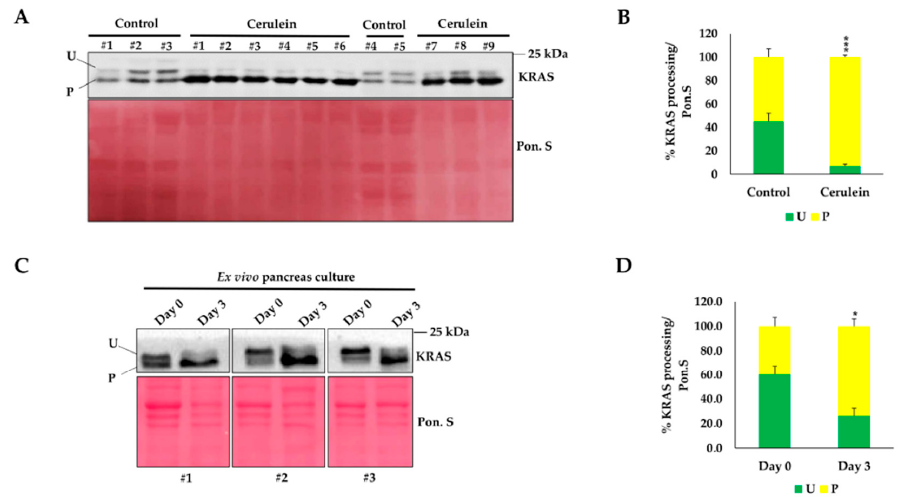
Figure 5. Impact of pancreas inflammation on KRAS prenylation. ( A ) Western blot on pancreas lysates from Ela-Kras G12D /+ mice treated ( n = 9) or not ( n = 5) with cerulein for 1 week. This result shows the di ff erential profiles of KRAS prenylation in the presence and absence of inflammation. ( B ) Densitometry quantification, from panel A, of unprenylated (green) and prenylated (yellow) KRAS forms normalized to Ponceau S (Pon.S), which is used as a loading control. ( C ) Western blot performed on protein lysates from ex vivo pancreas cultures at day 0 and day 3 using antibody #5 ( n = 3). Day 0 is equivalent to a normal pancreas and day 3 is equivalent to a metaplastic pancreas, similar to that observed in the presence of inflammation. ( D ) Densitometry quantification from panel C showing the proportion of unprenylated (green) and prenylated (yellow) forms of KRAS. Normalization was performed with Pon.S. U: unprenylated; P: prenylated. Data are mean ± SEM. Statistical significance was tested using student’s t -test (*: p < 0.05; ***: p < 0.001)